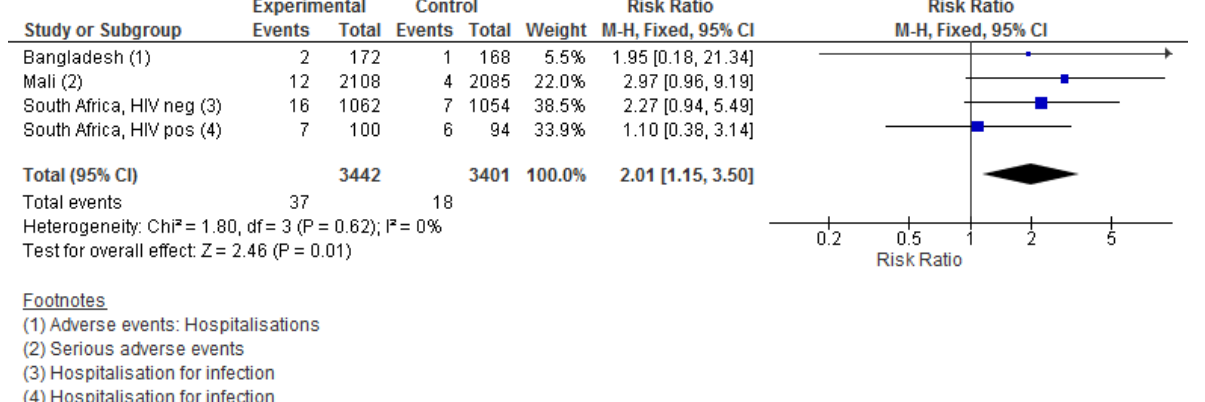
Figure 2. The effect of influenza vaccination in pregnancy on maternal non-influenza infectious adverse events. In Bangladesh, this was reported as hospitalisations. The following were considered infectious: fever; appendicitis; diarrhoea. In Mali, this was reported as serious adverse event. The following were considered infectious: chorioamnionitis; serious infection in pregnancy; peritonitis. In South Africa, this was reported as hospitalisations for infections. Among HIV-positive cohort, hospitalisation due to TB in the control group was excluded, as it was assumed as being